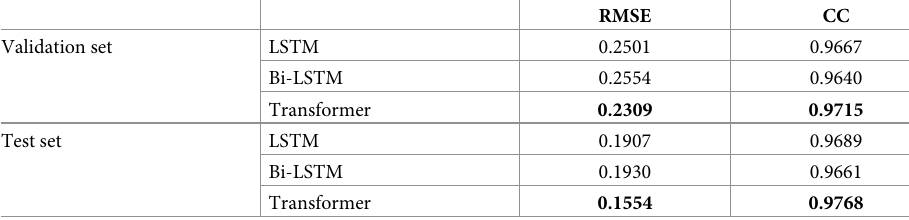
Table 1. Respiratory signal prediction accuracies of LSTM, Bi-LSTM, and the